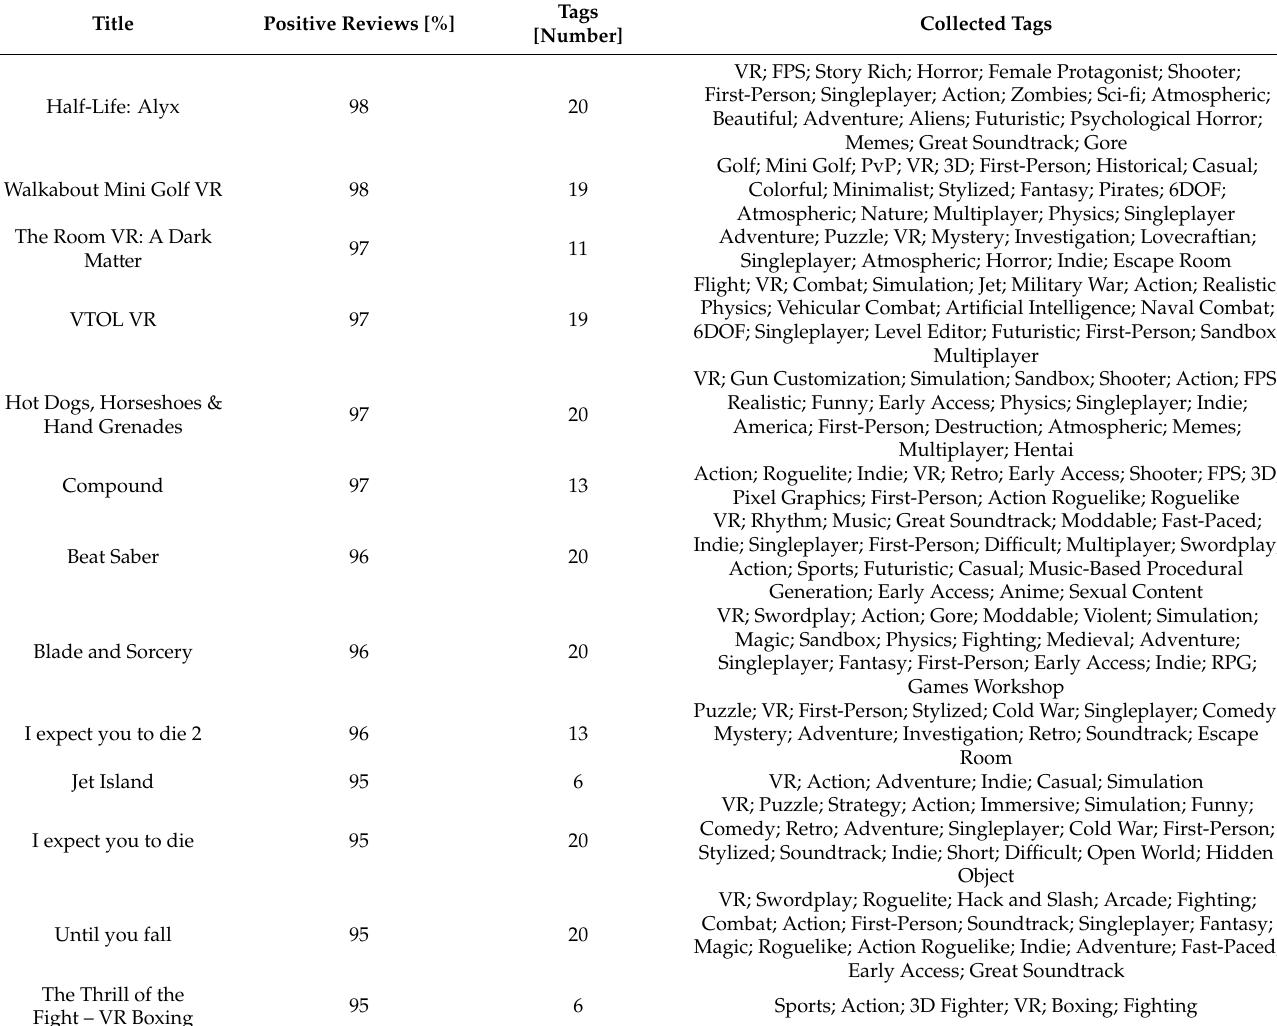
Table 10. VR applications with “overwhelmingly positive” reviews and the tags describing them— summary [state on 6 July